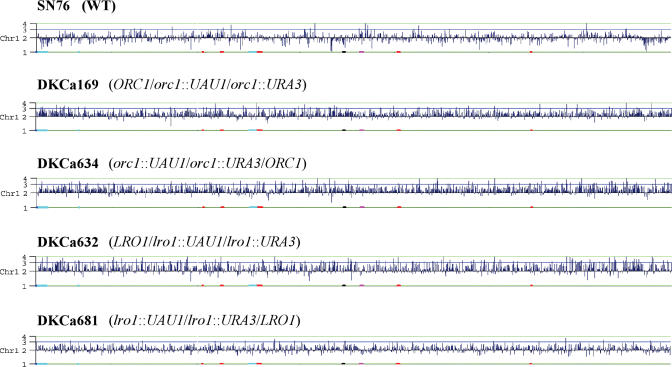
Chromosome Map Display of CGH Data on Ch1 for Arg+ Ura+ Derivatives and the Parental StrainA view of the extent of copy number changes plotted across the complete length of Ch1 using chromosome map [9]. CGH data were ordered along the chromosome as described in Materials and Methods. Data were plotted as log2 values, which correspond to the chromosome copy number indicated on the y-axis.